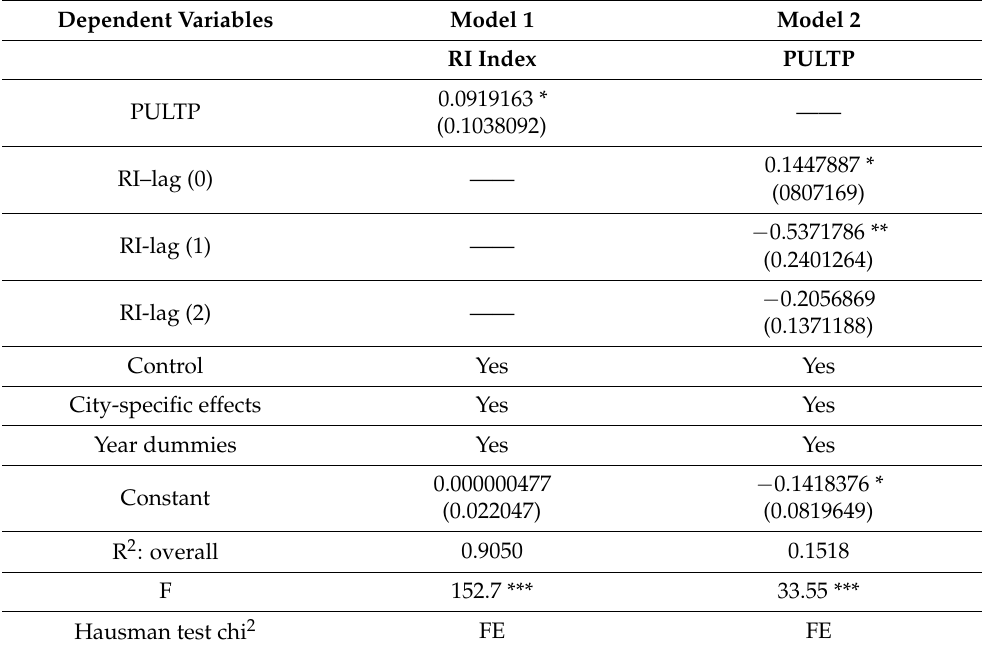
Table 6. Results of the robustness